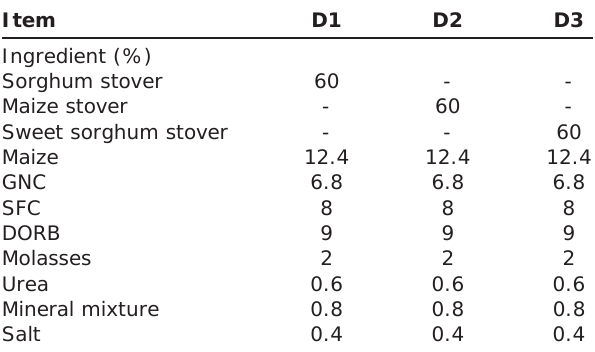
Table-1: Ingredient composition of experimental